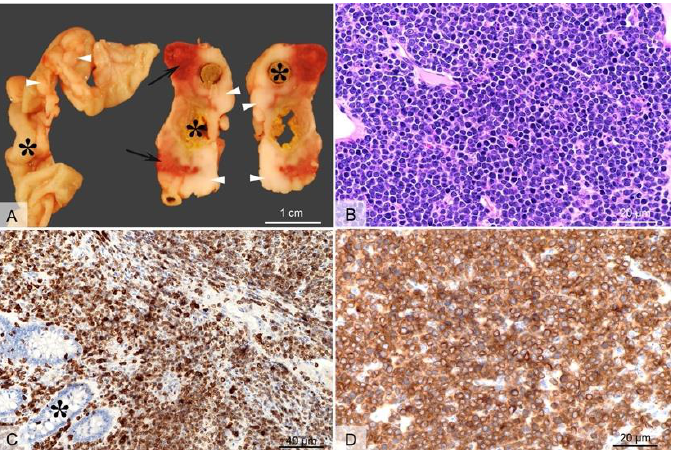
Figure 1. Gross and microscopic images of an intestinal T cell lymphoma in a KCNQ1 homozygous mutant hamster. Grossly ( A ), extending from the intestinal wall through the serosa and mesentery, there are multifocal to coalescing white-beige masses (arrow heads), with focal areas of necrosis and hemorrhage (arrows). The tumors circumferentially surround the intestines (indicated by asterisks) which are occasionally moderately dilated and segmentally ulcerated (transmural). Histologically, the tumor consists of densely packed sheets of round to oval cells with scant basophilic cytoplasm ( B ) that infiltrate the intestinal mucosa (( C ), asterisk) and subjacent layers through to intestinal serosa. The cells show a uniform, intense immunolabeling of plasma membrane for CD3 ( C , D ) (anti- CD3 antibody, DAKO/Agilent, Santa Clara, CA, USA; Cat# A0452). H&E, 40 × objective Panel ( B ); CD3 immunolabeling with 20 × objective Panel ( C ), and with 40 × objective Panel ( D ) (from [46], with